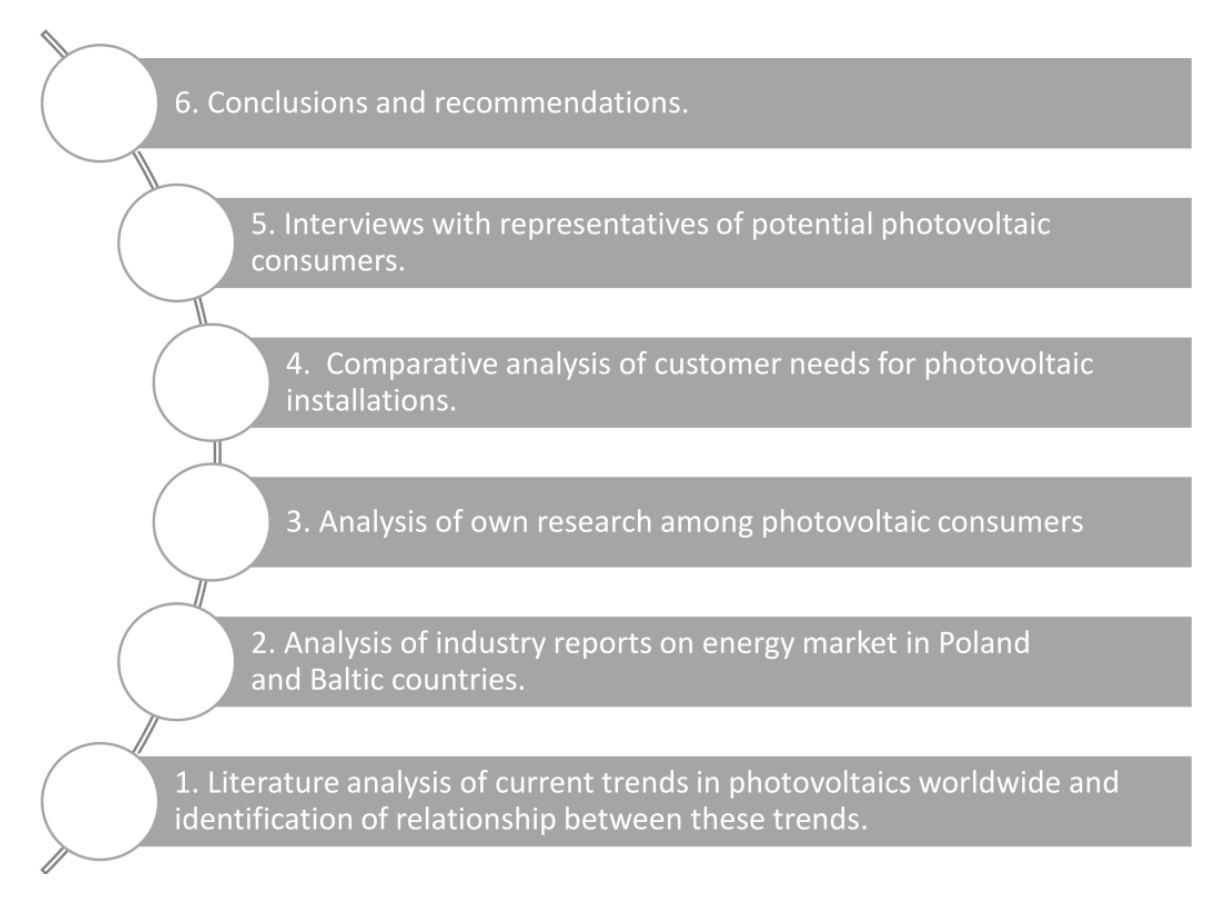
Figure 1. Research algorithm